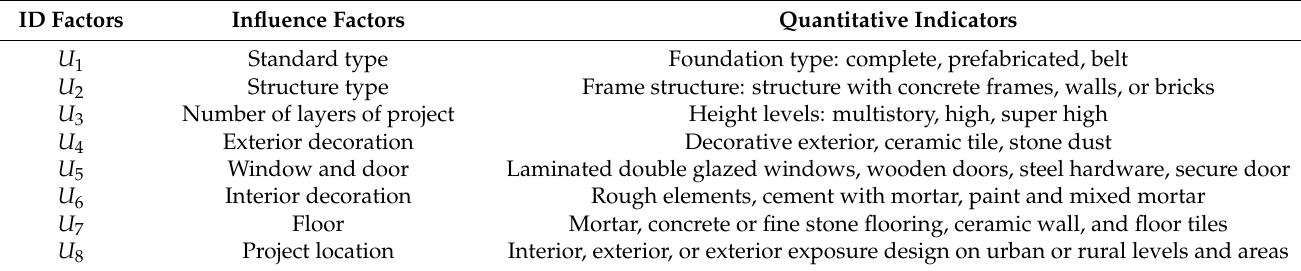
Table 1. Exposure of the vector quantization index of the technical type